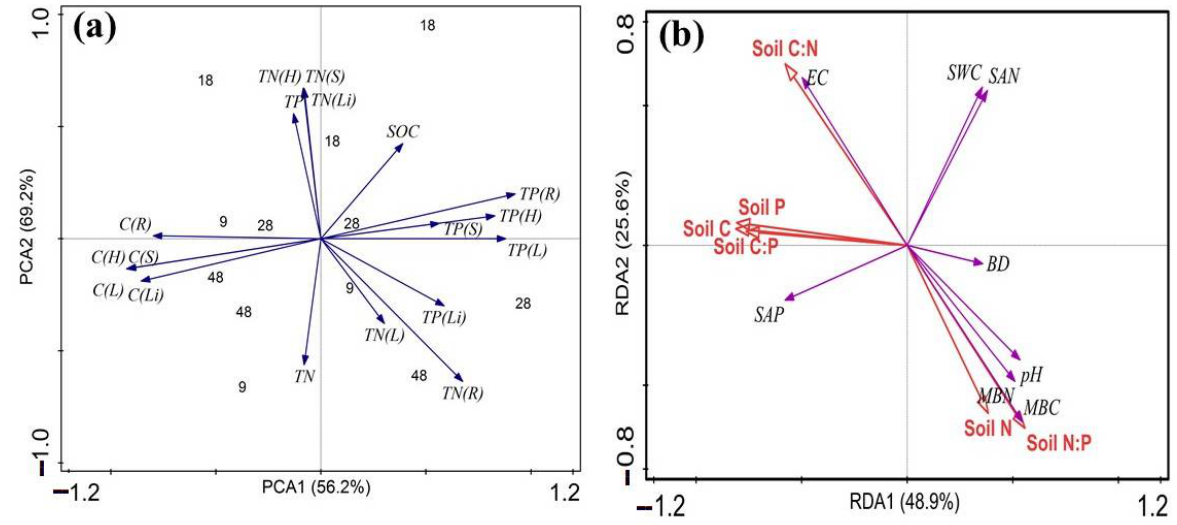
Figure 8. ( a ) The relationship between plant components (blue-arrows) and C:N:P contents (red- arrows) in the stand age of P. massoniana plantations chronosequence was determined using principal component analysis (PCA). ( b ) Redundancy analysis (RDA) was used to determine the relationships between soil properties (blue-arrows) and C:N:P ratios (red-arrows) in different stand age treatments (9-, 18-, 28-, 48-year). Soil available phosphorus (SAP), microbial biomass carbon (MBC), microbial biomass nitrogen (MBN), soil water content (SWC), bulk density (BD). The relationship between the contents of C, N, and P, and stoichiometric ratios with